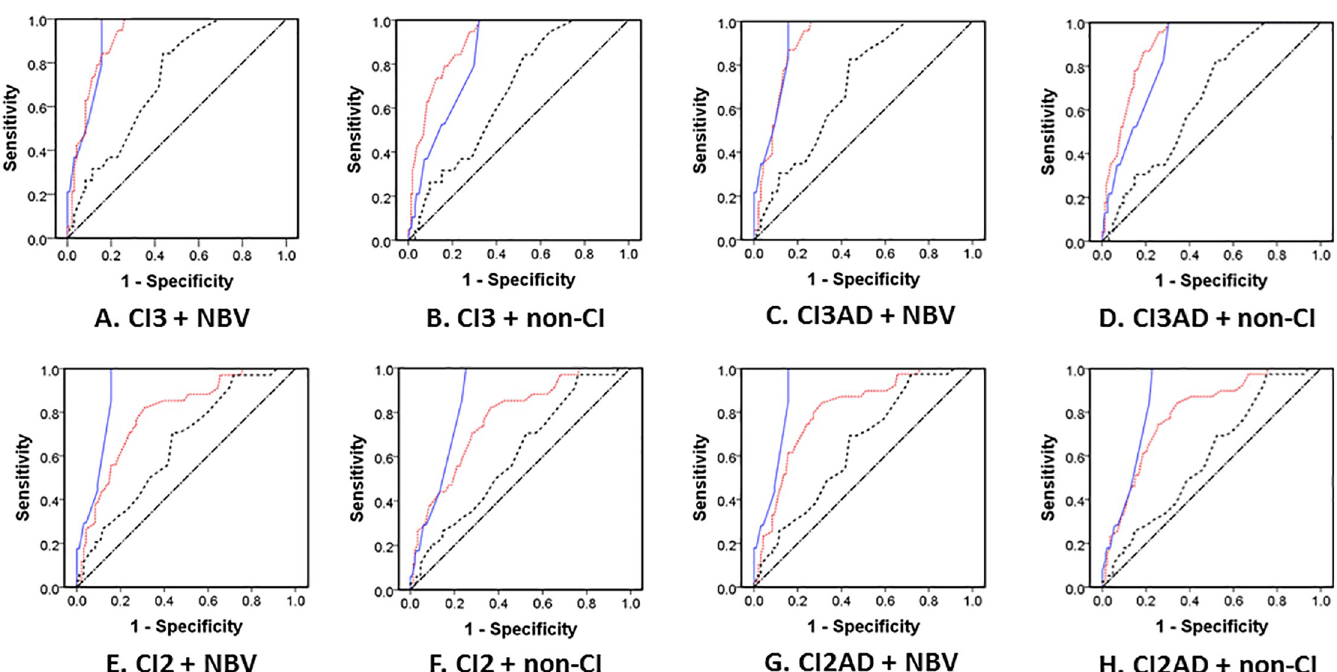
Fig 1. ROC curves for NPC and Sheard’s and Percival’s criterion according to the combined CI groups. Blue solid line: NPC, red dotted line: Sheard’s criterion for near, dashed line: Percival’s criterion for near, diagonal line: no discrimination (AUC = 0.5).